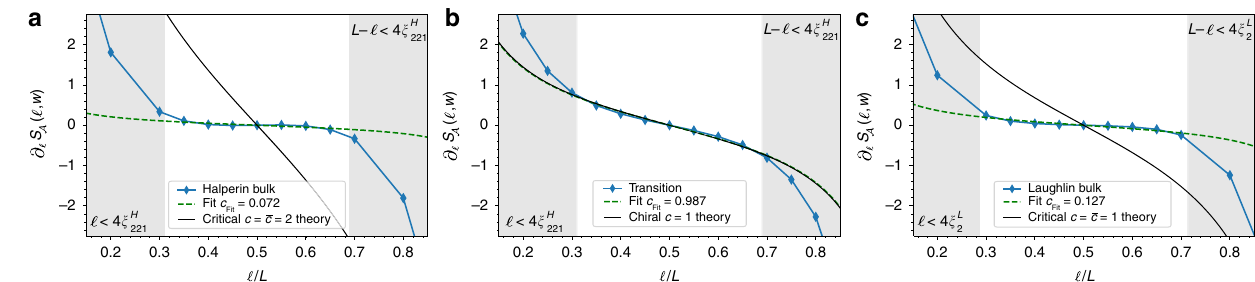
‘; w Þ for a Levin – Wen type cut Fig. 5 Critical contribution of the EE at the interface: fi tting procedure to characterize the critical contribution to the EE S A ð depicted in Fig. 3. a far in the Halperin bulk, b for a patch covering the interface, and c deep in the Laughlin phase. All data points were taken for a cylinder perimeter L ¼ 12 ‘ B , a patch width w ¼ 2 : 75 ‘ B and a truncation parameter P max = 12. To mitigate fi nite size effects, we discard the points for which ‘ or L (cid:2) ‘ are smaller than four times the correlation length (gray shaded area in the plots). To estimate these regions we use the bulk Halperin 221 correlation length ξ H 0 : 941 ‘ B in a , b and the Laughlin 1/2 bulk correlation length ξ L 0 : 858 ‘ B , which we had previously extracted 44 . We only see a critical 221 ’ 2 ’ contribution when the patch covers the transition region and is large enough (see Supplementary Fig. 4), as expected. The prediction from critical theories are plotted in black while the result of the fi t are shown with dashed green